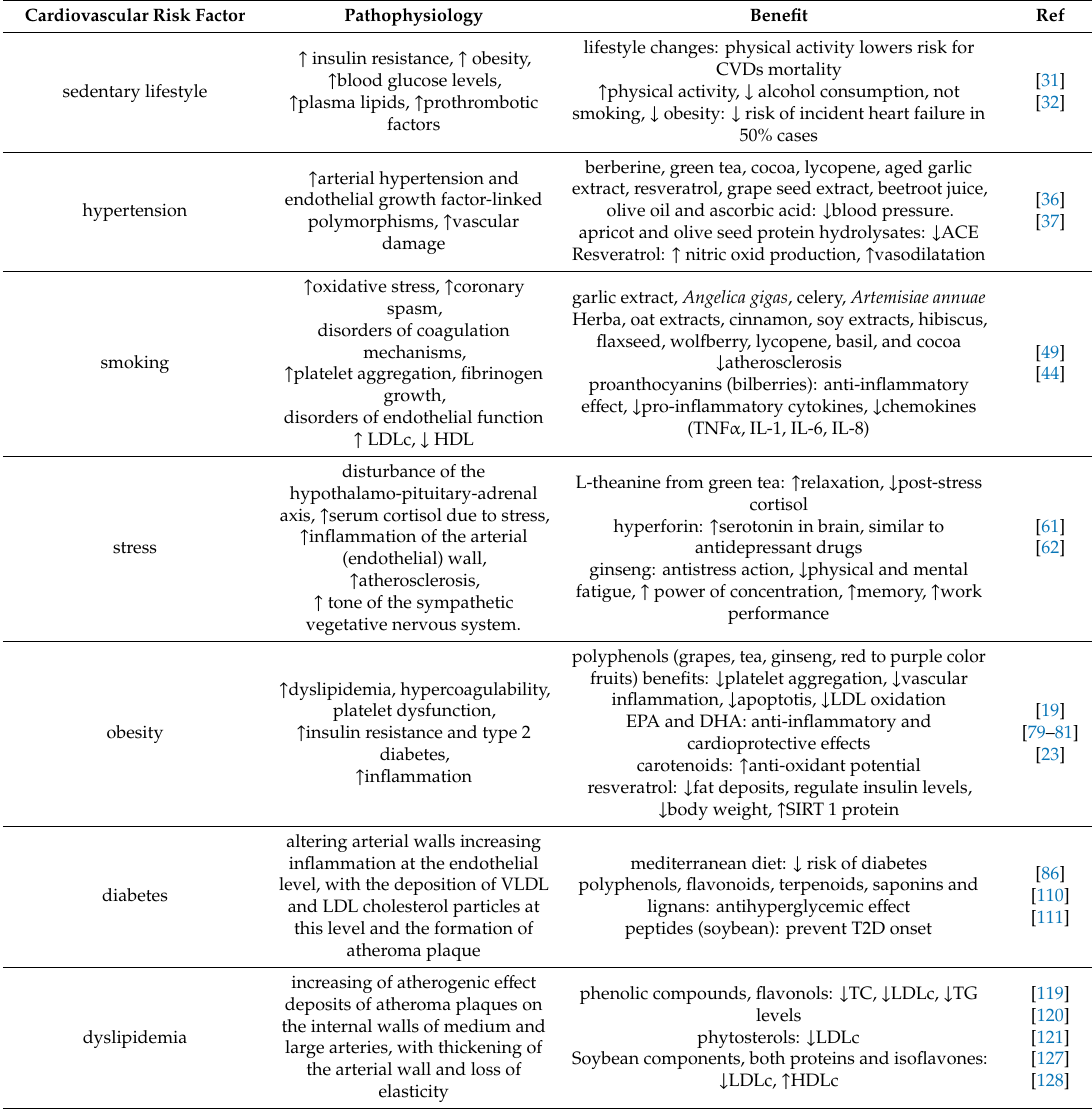
Table 1. Benefits of Plant-derived Bioactive Constituents and Lifestyle Changes on Risk Factors in Cardiovascular